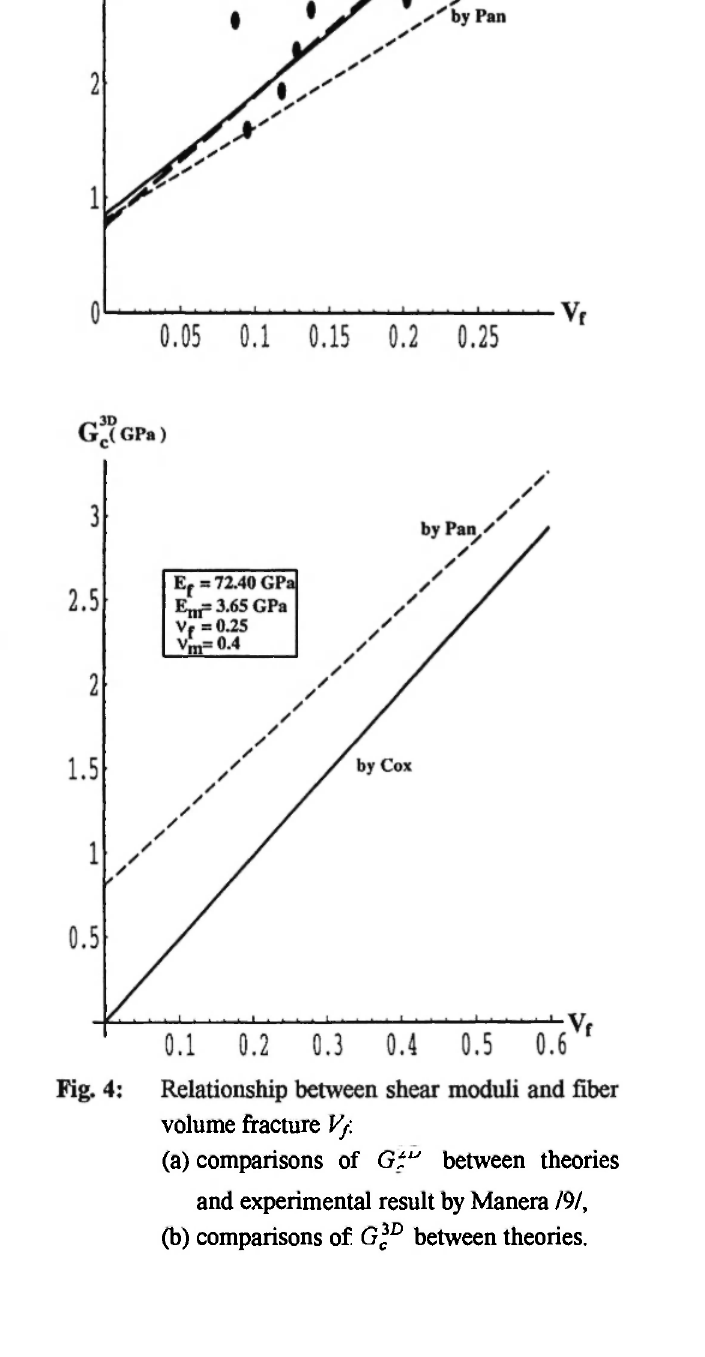
Fig. 3: Theoretical predictions of relationship between £ C3D and V